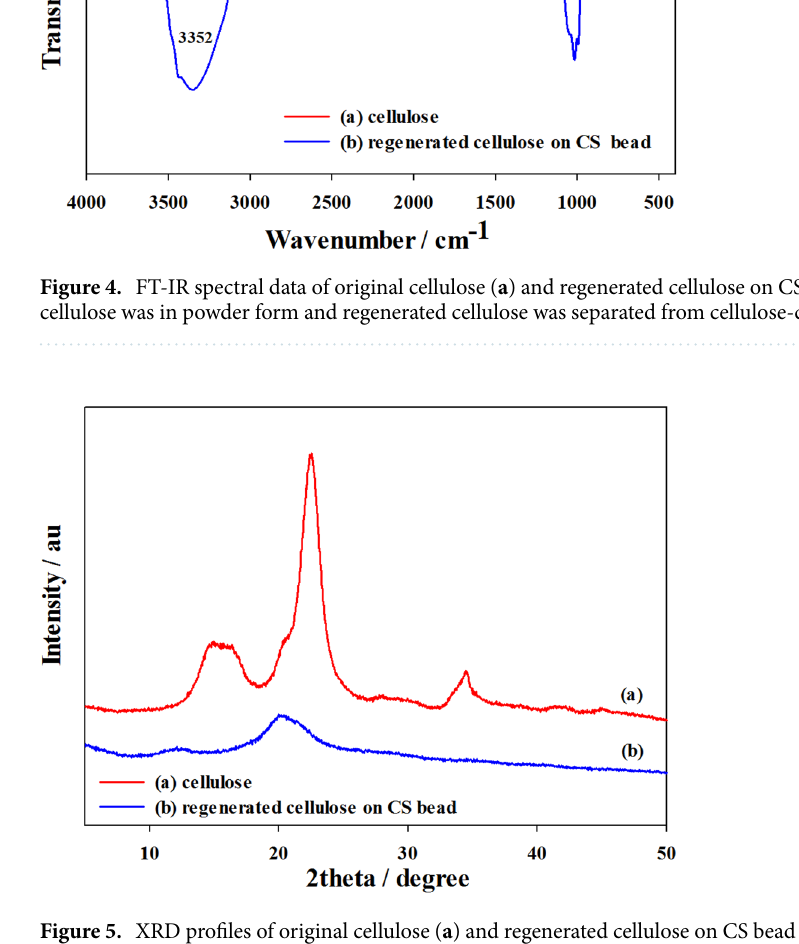
Figure 5. XRD profiles of original cellulose ( a ) and regenerated cellulose on CS bead ( b ). Original cellulose was in powder form and regenerated cellulose was separated from cellulose-coated CS